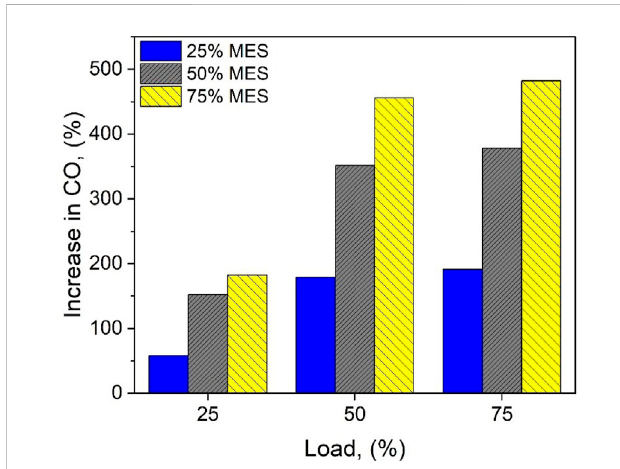
FIGURE 8 PercentagechangeinCOemissionswithrespectto dieselfuelwith varying MES level at different loads.